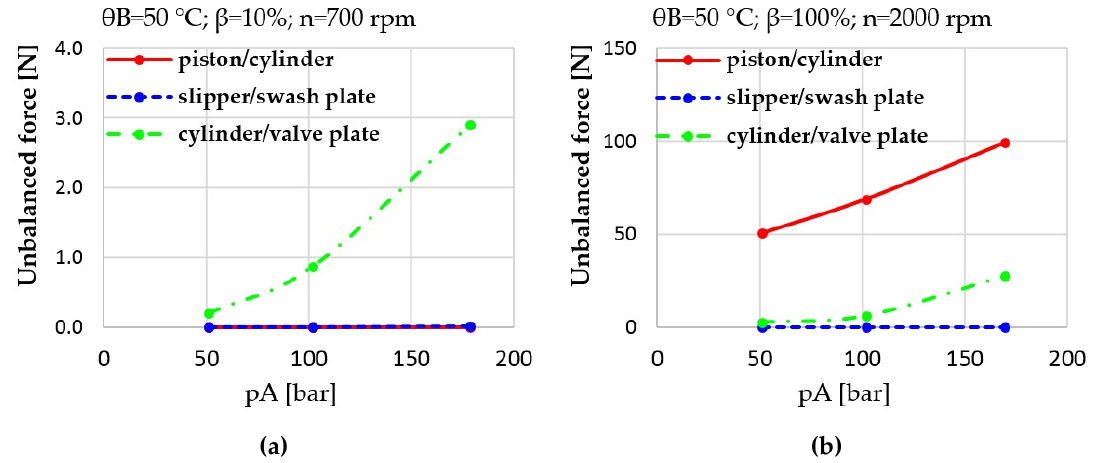
( a ) Unbalanced forces in the individual lubricating interfaces at low power Figure 19. (a) Unbalanced forces in the individual lubricating interfaces at low power operating operating condition; ( b ) unbalanced forces in the individual lubricating interfaces at high power condition; (b) unbalanced forces in the individual lubricating interfaces at high power operating operating condition.